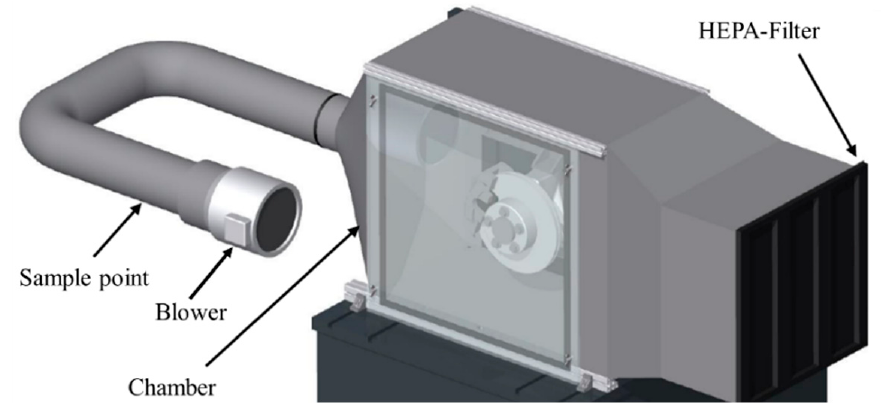
Figure 4. Constant volume sampling (CVS) system—A HEPA filter is installed on the right side of the enclosure. Arrows indicate the PM and PN sampling probes employed in the study [38].